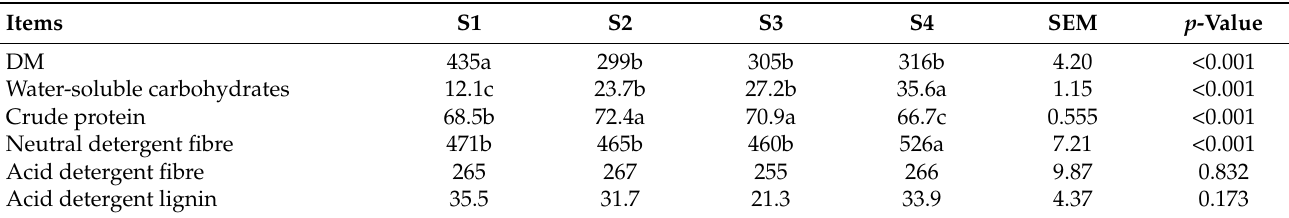
Table 6. Dry matter content (DM, g/kg) and chemical component concentrations (g/kg DM) of whole-plant corn silages (n =